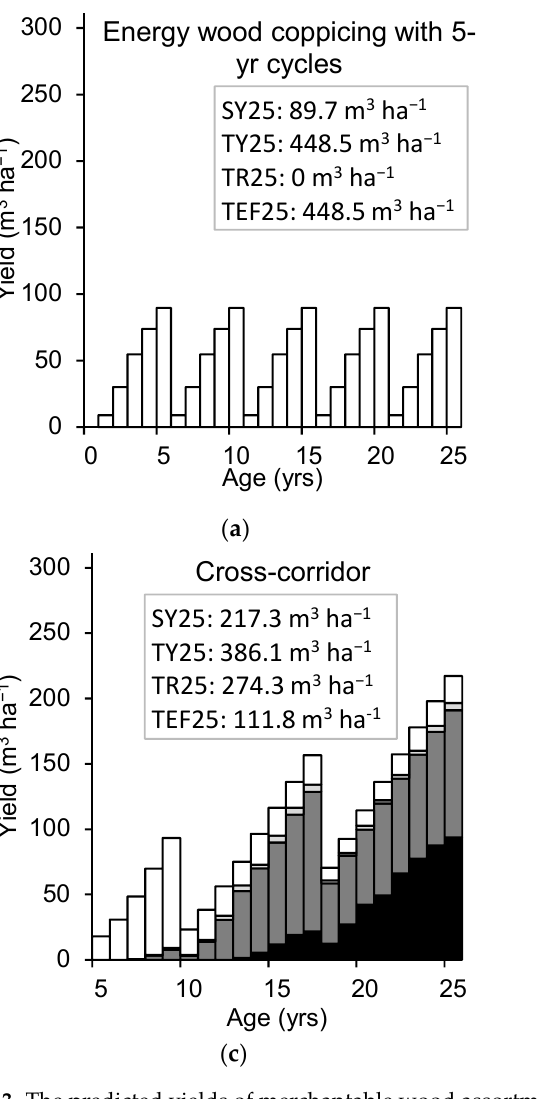
Figure 3. The predicted yields of merchantable wood assortments according to the four compared management scenarios: ( a ) energy-wood coppicing; ( b ) corridor thinning; ( c ) cross-corridor thinning; ( d ) single-tree thinning. The standing volumes (SY25) and the total yields (TY25) at the age of 25 years as well as the total yields of roundwood (TR25) and the total combined yields of energy and fuelwood (TEF25) during 25 years are shown in text boxes.